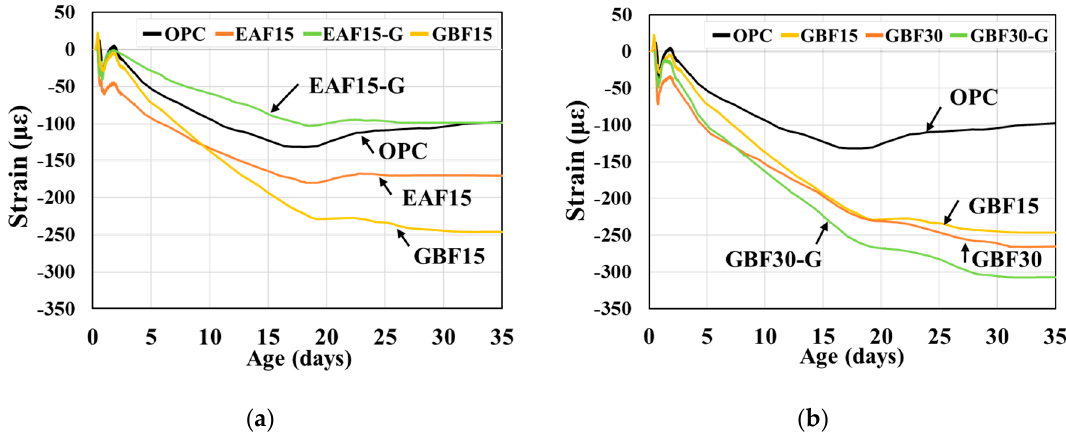
Figure 3. Results of autogenous shrinkage. ( a ) Results of EAF series and ( b ) results of GBF series.